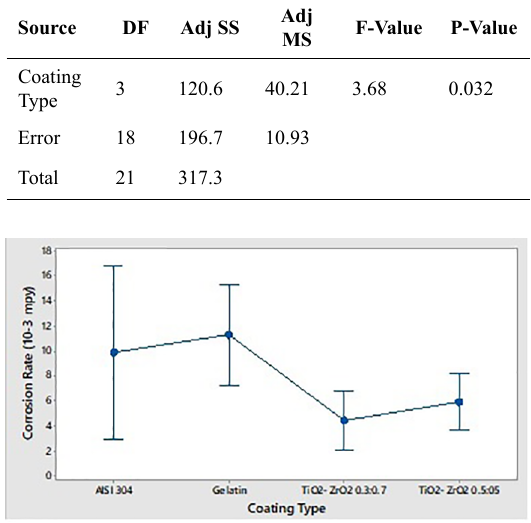
Table 4. ANOVA test results of the corrosion rate versus coating type.